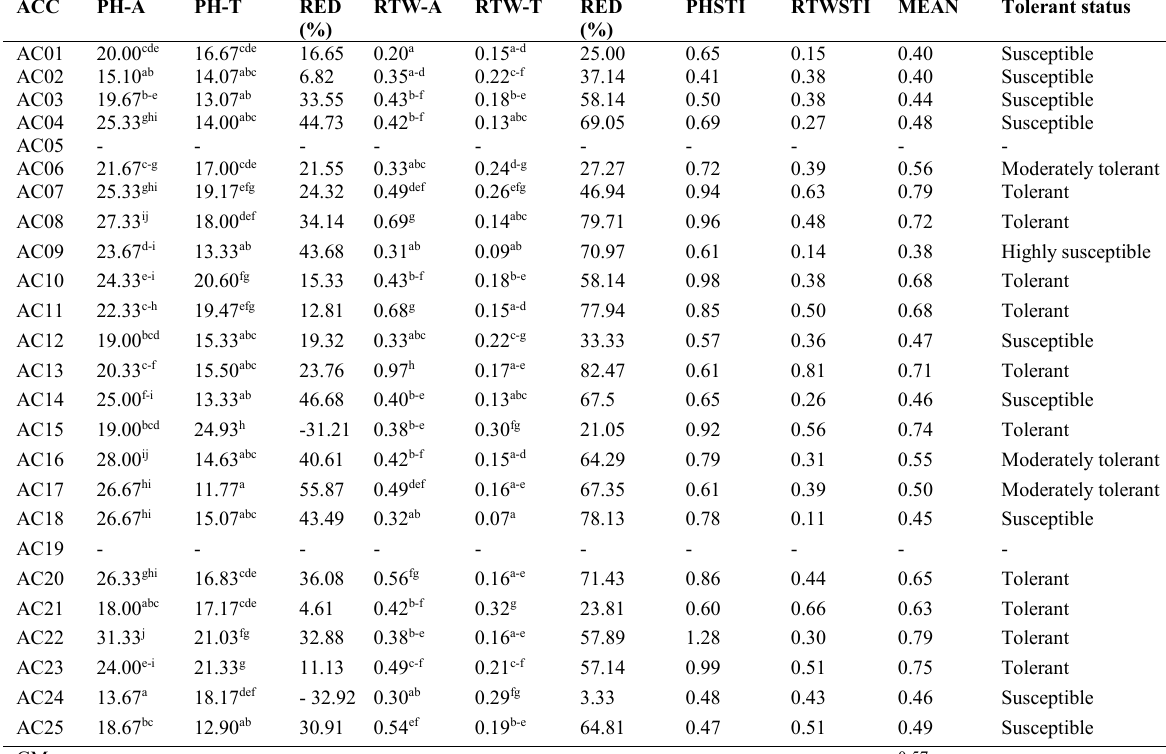
Table 4. Mean performance for plant height and root weight of accessions of cowpea under control (A) and drought stress (T)